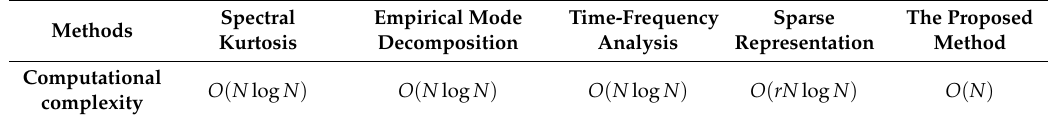
Table 1. Computational complexity comparison.